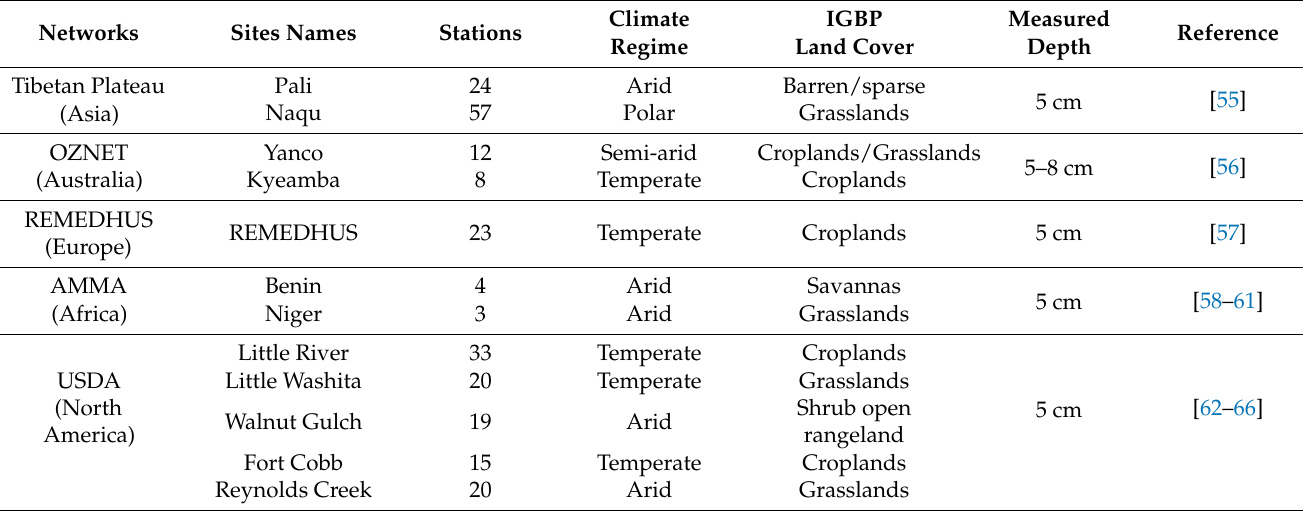
Figure 2. Locations of validation sites (the background map is the land use and land cover map based on MCD12C1 data in 2019). Table 2. List of validation sites.